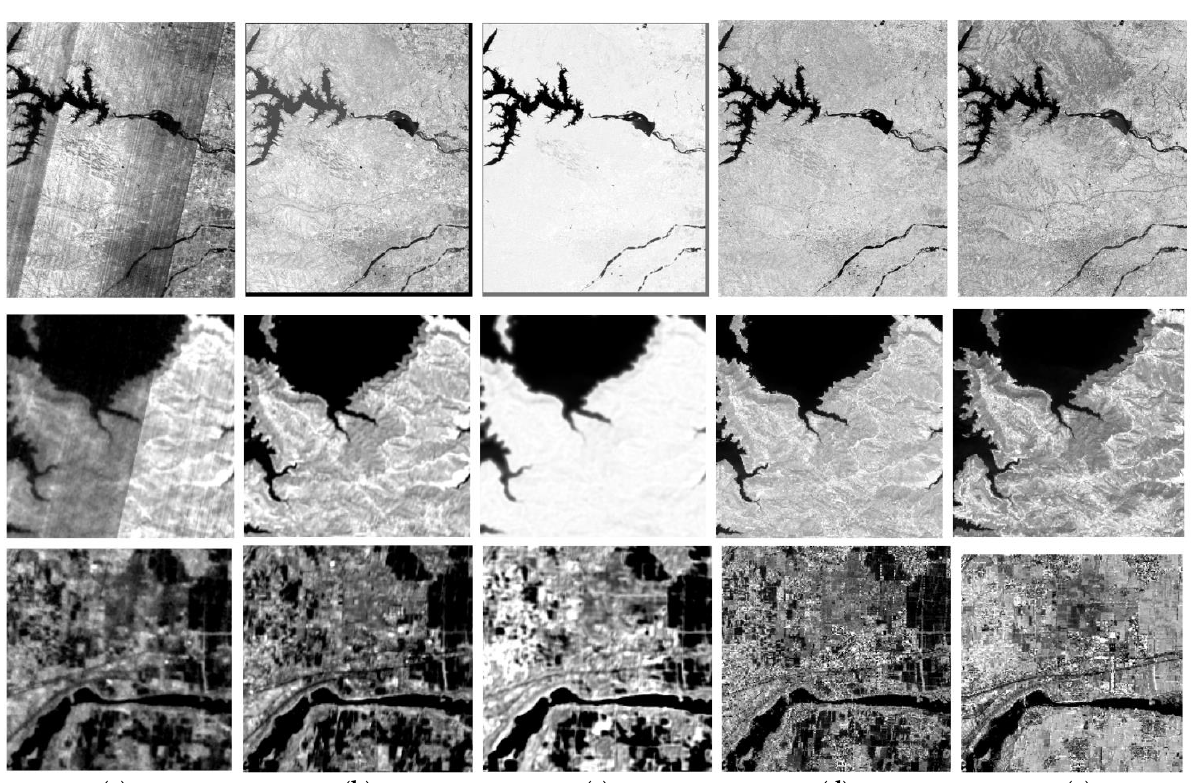
Figure 14. Image of Band 125 of dataset II. ( a ) Original Image, ( b ) SRE-ResNet, ( c )